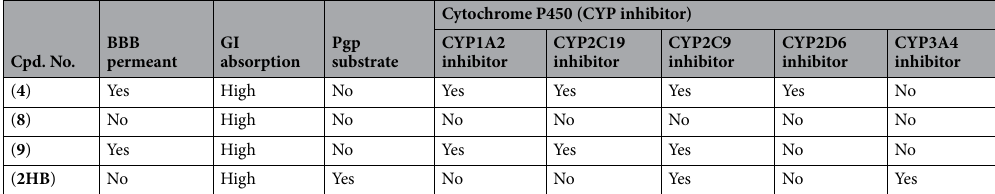
Table 5. In silico pharmacokinetic study of compounds 4, 8, and 9 as well as the reference 2HB.